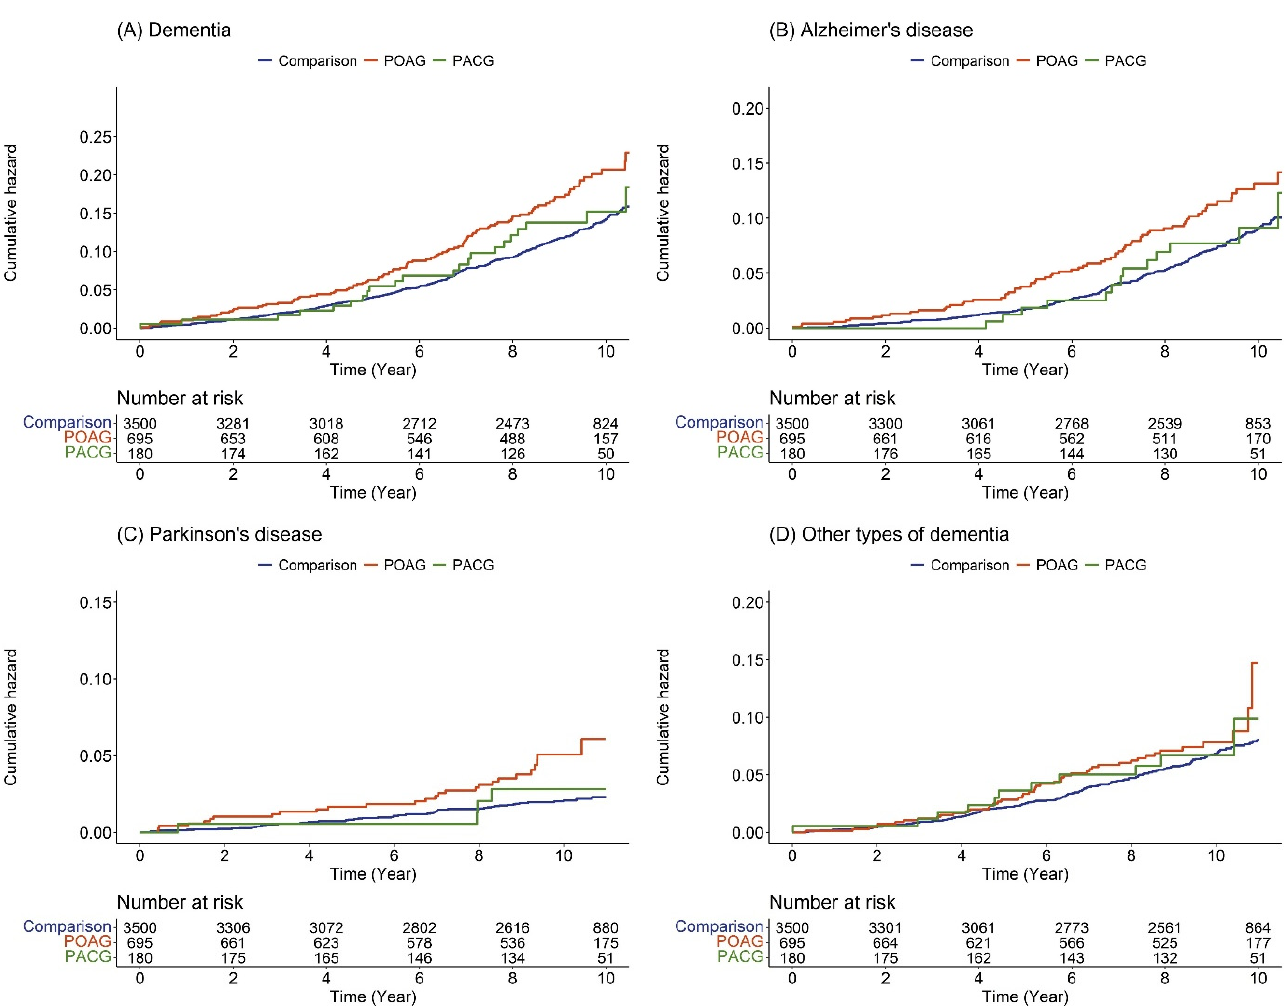
Figure 3. Cumulative hazard plot of specific diseases among comparison, POAG, and PACG: ( A ) dementia; ( B ) Alzheimer’s disease; ( C ) Parkinson’s disease; ( D ) other types of dementia. POAG, primary open-angle glaucoma; PACG, primary angle-closure glaucoma.